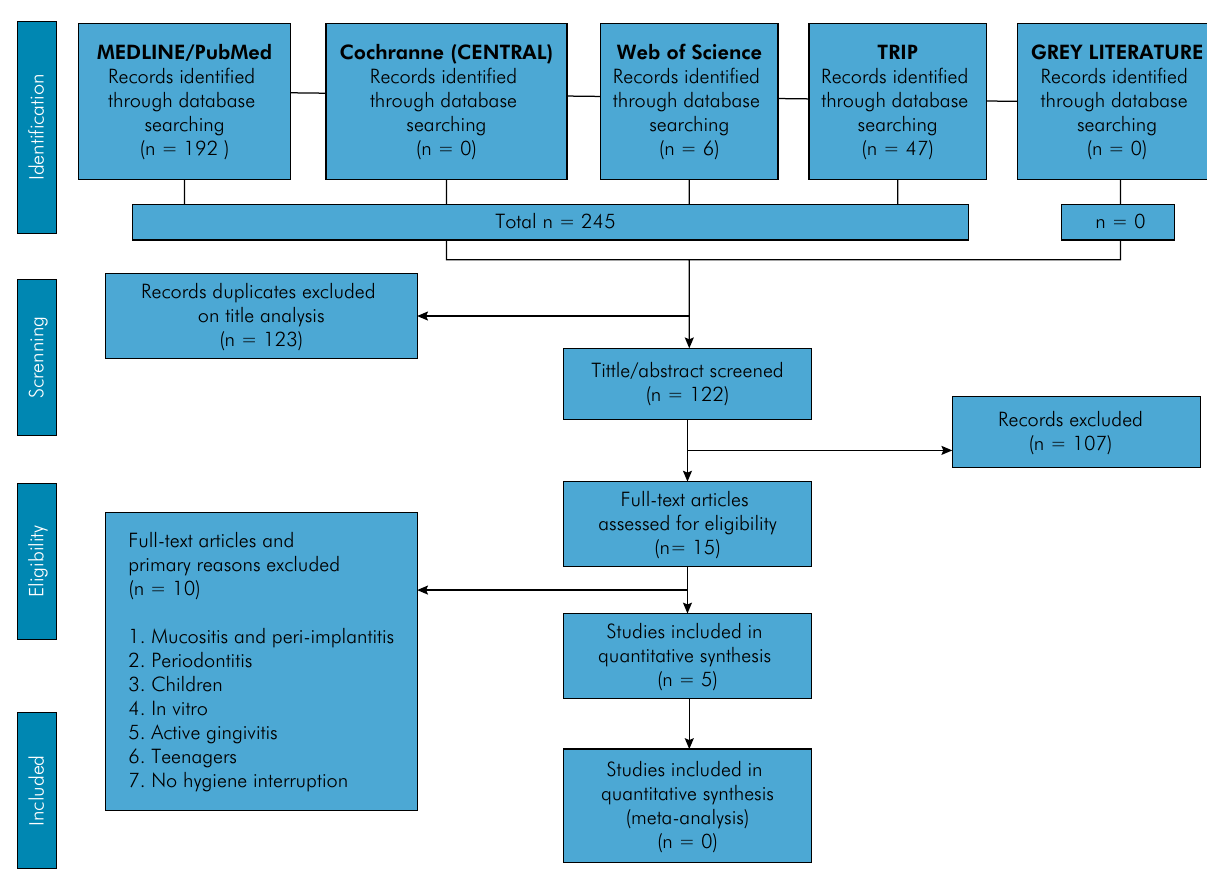
Figure. Flow diagram of the screening and selection